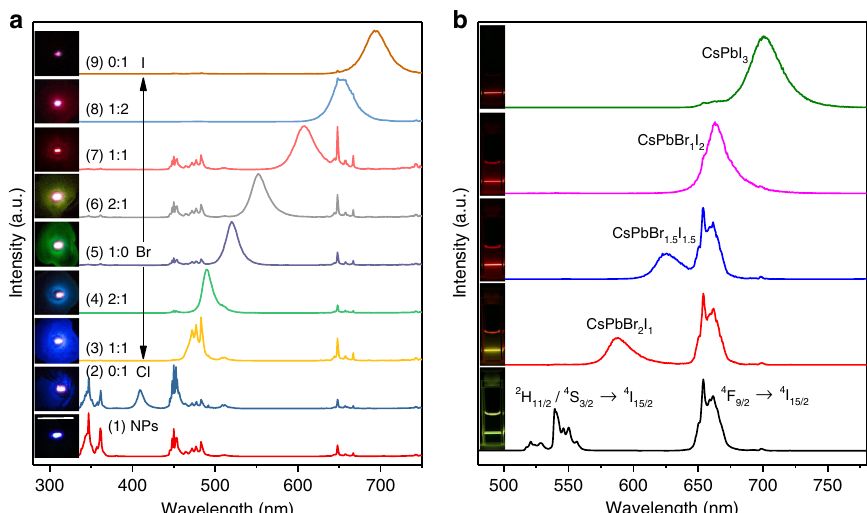
Fig. 6 Generality of the proposed radiative energy transfer upconversion (RETU) for sensitizing photon upconversion in CsPbX 3 perovskite quantum dots (PeQDs). a Upconversion luminescence (UCL) spectra for LiYbF 4 :0.5%Tm 3 + @LiYF 4 core/shell nanoparticles (NPs) and the NP-sensitized CsPbX 3 PeQDs (NPs: 1 mg mL − 1 ; PeQDs: 2 mg mL − 1 ) with varying halide compositions by casting them onto glass substrate under 980 nm CW diode laser excitation at a power density of 50 W cm − 2 . The insets show the corresponding UCL photographs for the NP-sensitized PeQDs, and the scale bar represents 1 cm. b UCL spectra for NaYF 4 :18%Yb 3 + , 2%Er 3 + NPs (approximately 23 nm) and the NP-sensitized CsPbX 3 PeQDs (NPs: 1 mg mL − 1 ; PeQDs: 2 mg mL − 1 ) with varying halide composition under 980 nm CW diode laser excitation at a power density of 20 W cm − 2 . The insets show the corresponding UCL photographs